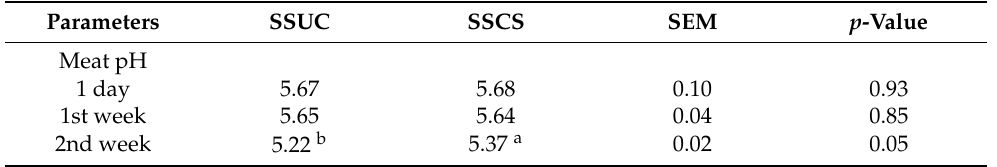
Table 3. Effect of slaughtering with or without state of consciousness on Longissimus dorsi muscle’s pH in Korean Hanwoo Finishing Cattle during storage at 4 ◦ C.